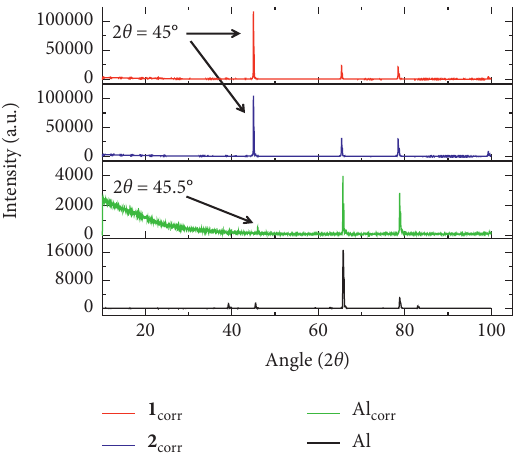
Figure 5: X-ray diffraction of aluminium (before and after cor- rosion) and Al after scrapping of electrodeposited phthalocyanines following corrosion (represented as 1 corr and 2 corr ).